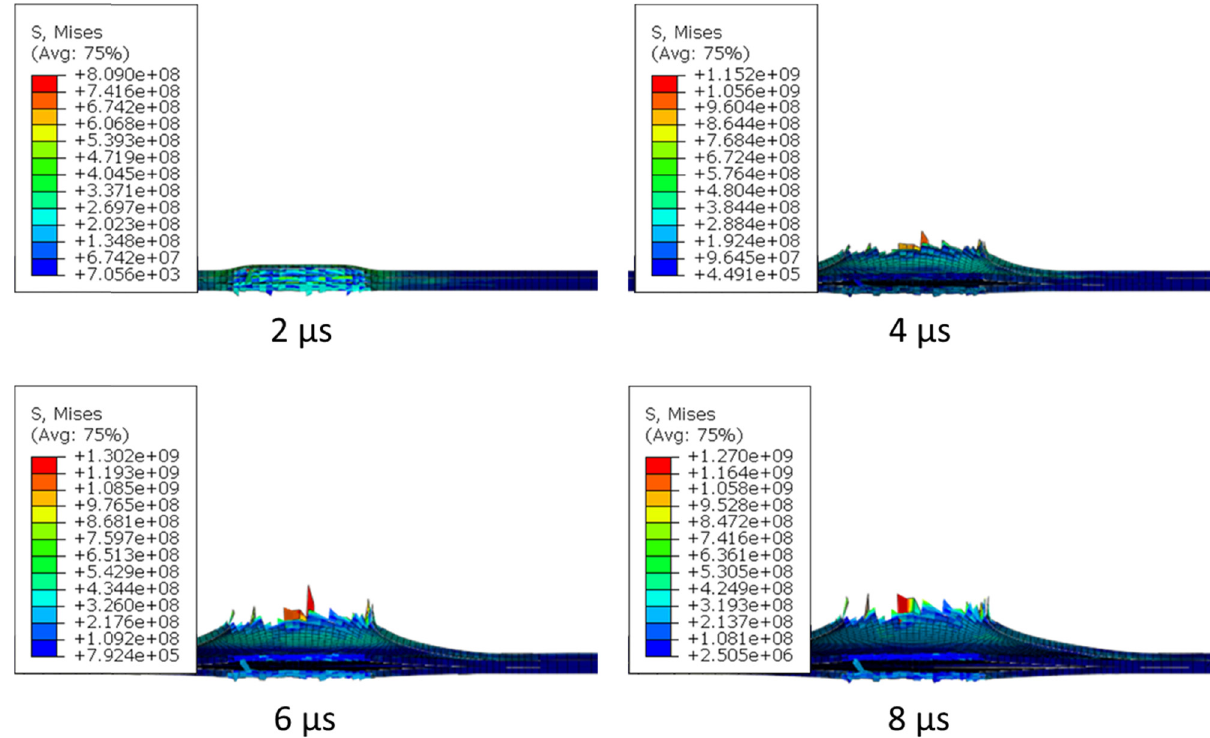
Figure 10: Stress distribution and deformation for model 3 against blunt projectile.